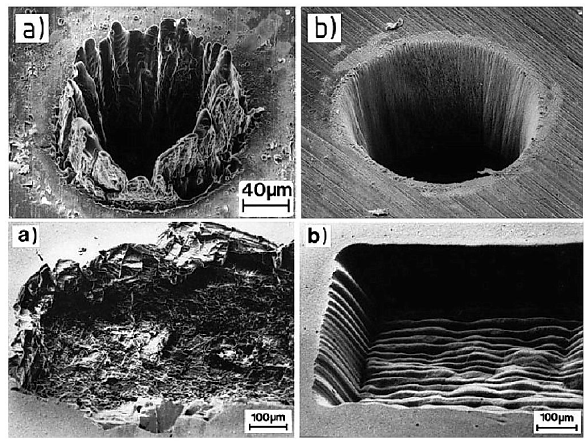
Figure 1: Shape comparison of machined elements using different pulse duration; (a) machining by a nanosecond pulsed beam, (b) machining by a femtosecond pulsed laser beam [25].